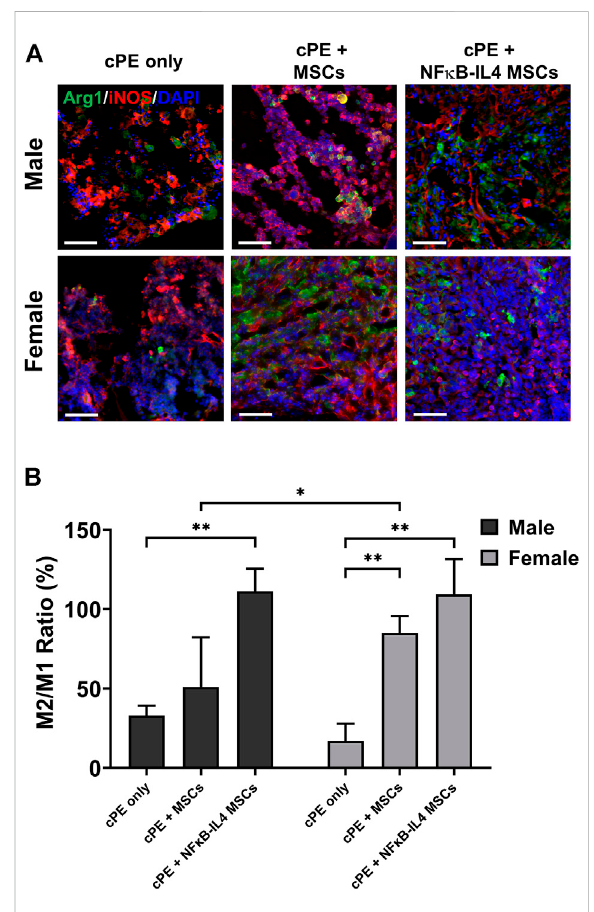
FIGURE 7 Immuno fl uorescent (IF) staining analysis for M1 and M2 macrophages in each group. (A) representative images of Immuno fl uorescent for M1 macrophages (iNOS + , Red) and M2 macrophages (Arg1 + , Green), Scale bar = 50 μ m. (B) quantitative analysis for cell proportion change of M2/M1 ratio. After cell treatment, males showed signi fi cantly increased M2/ M1 ratio in NF κ B-IL-4 MSCs group. In females, both MSCs and NF κ B-IL4 MSCs groups showed signi fi cantly increased M2/ M1 ratio compared to sex-matched control group. In MSC groups, females showed a signi fi cant increase compared to males. (Males, cPE only group: n = 5, cPE + MSCs group: n = 7, cPE + NF κ B-IL4 MSCs group: n = 5; Females, cPE only group: n = 5, cPE + MSCs group: n = 7, cPE + NF κ B-IL4 MSCs group: n = 5; * p < 0.05, ** p < 0.01, Two-way ANOVA comparedto sex-matchedcontrol